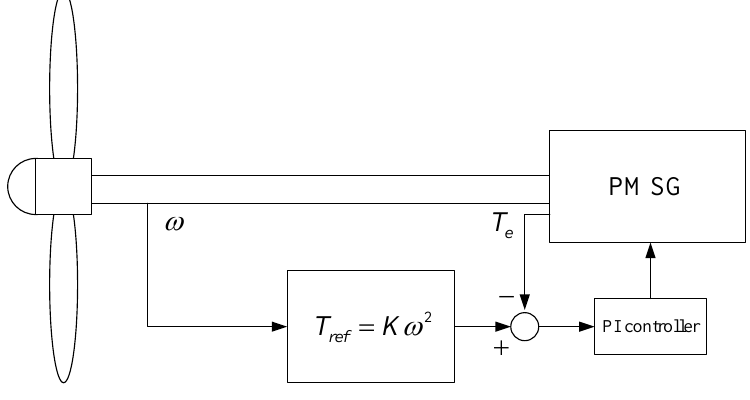
Figure 11. Control system configuration in Region 2. Table 3. The dominant parameters of 2 MW wind turbine.